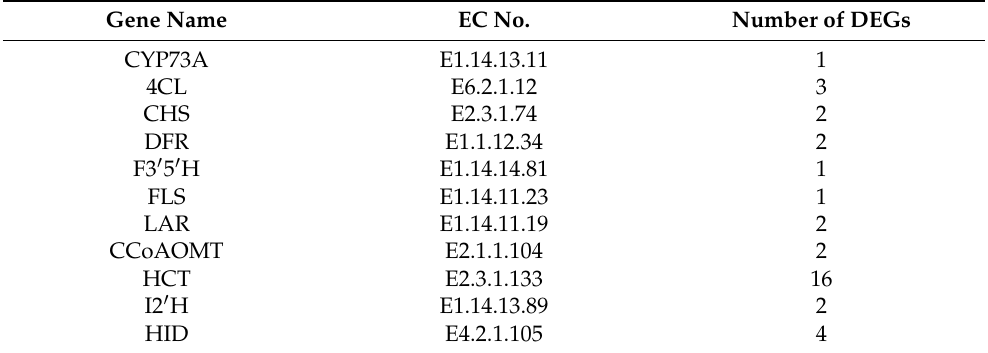
Table 5. Genes associated with flavonoid biosynthesis were identified in the transcriptome of R. liliiflorum